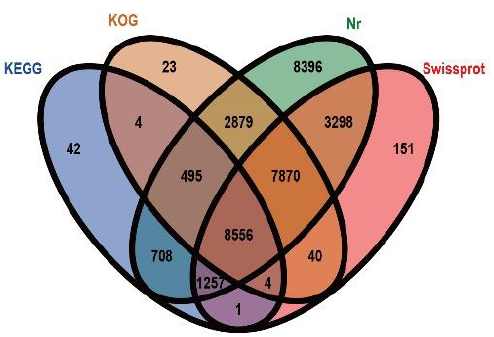
Figure 2. Venn diagram of the number of unigenes annotated by BLASTx with four protein databases.